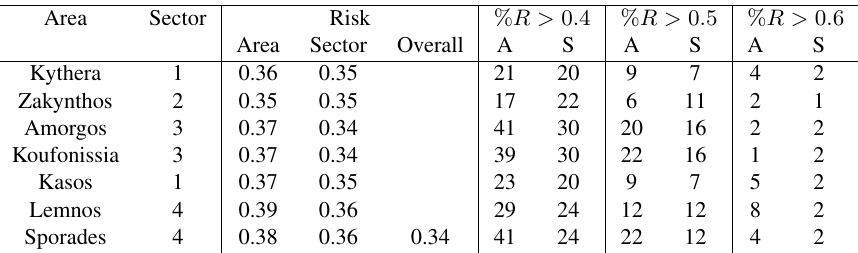
Table 2: Aggregated risk results. Table shows the average risk differences between each area of interest and corresponding general